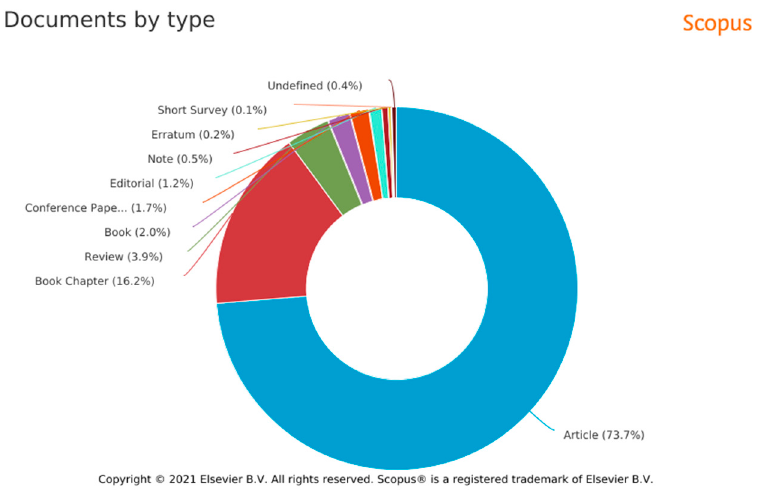
Figure 3. Publications on translanguaging by document type (https://www.scopus.com/home.uri, accessed on 12 February 2021).